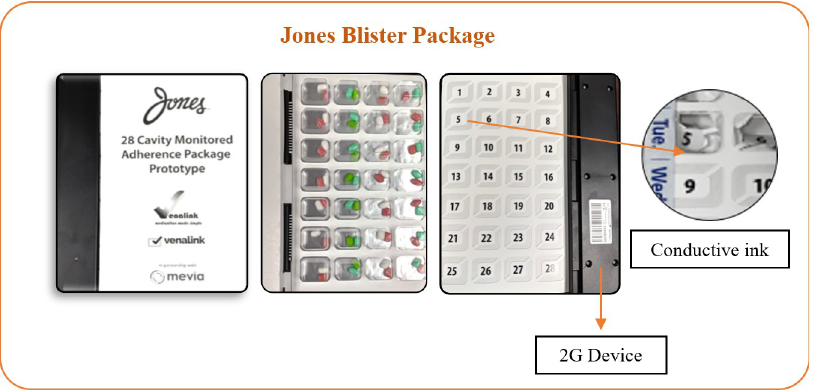
Fig 1. Smart multidose blister